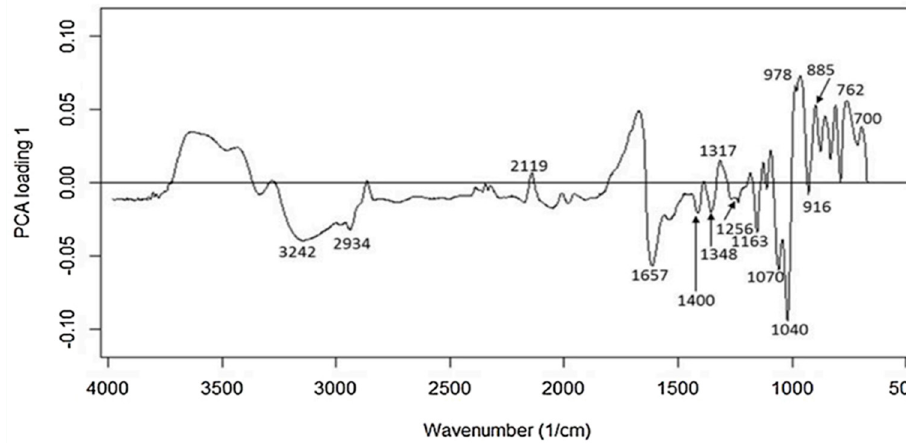
Figure 3. ATR–FTIR spectrum. Adopted from [193].